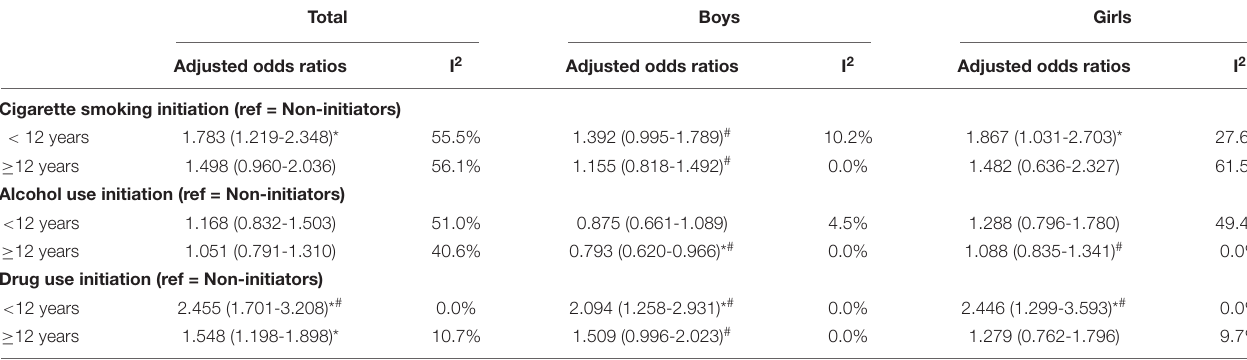
TABLE 3 | Adjusted a relationships between the early initiation of substance use and attempted suicide among in-school African